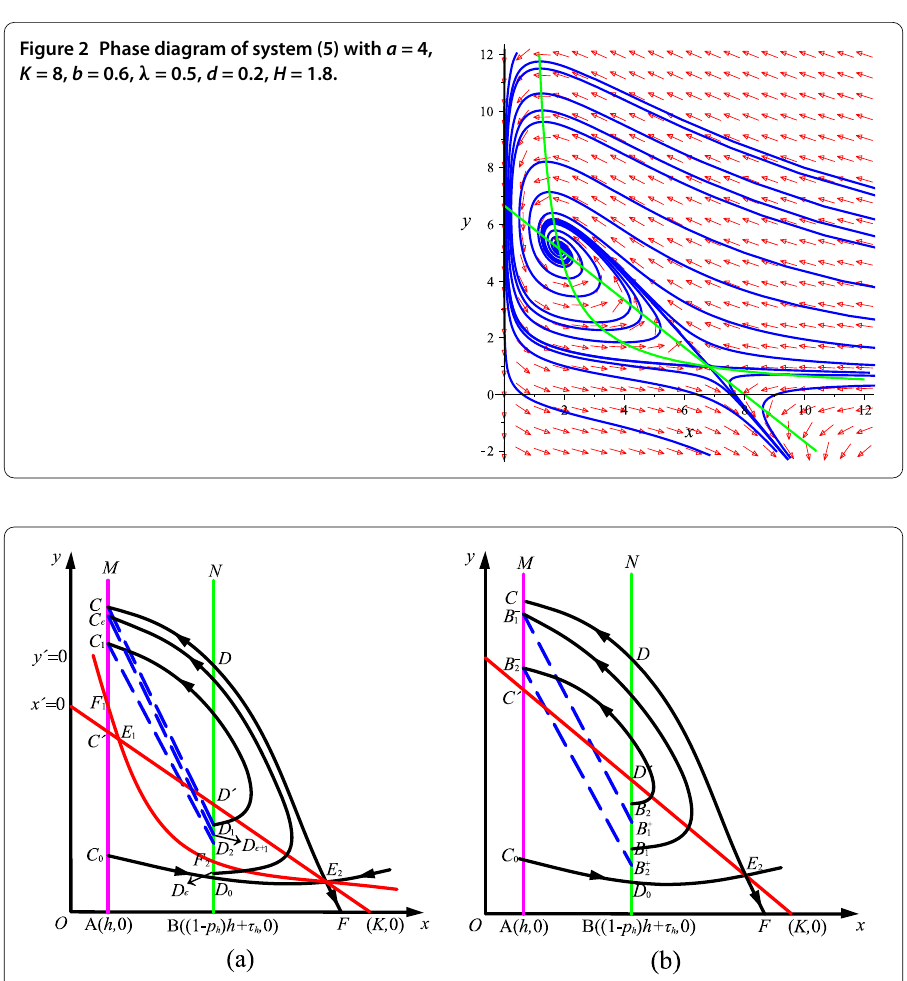
Figure 3 The existence and uniqueness of the order-1 periodic solution of system (2) in Case I. (a) The existence of the periodic solution. (b) The uniqueness of the periodic